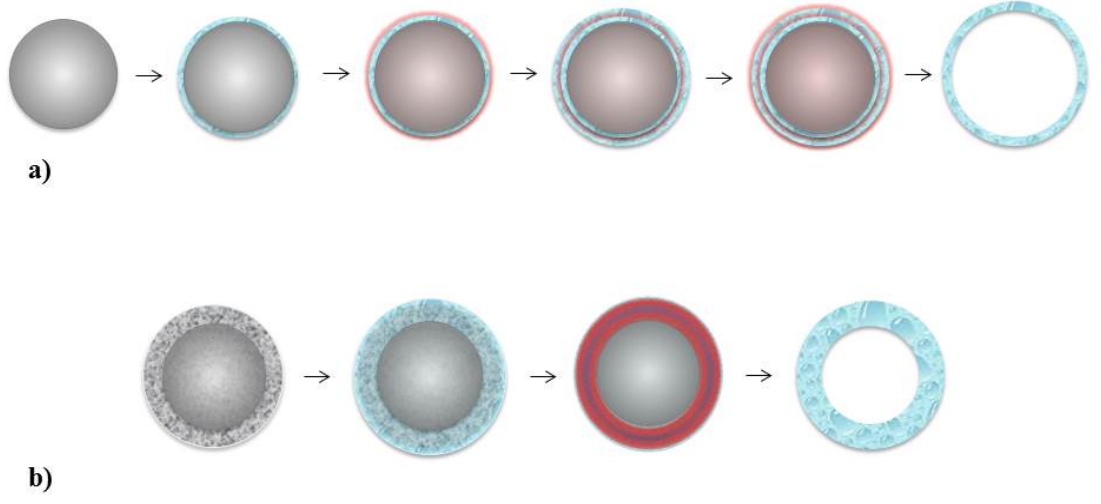
Figure 1. Schematic representation of ( a ) LbL assembly process, and ( b ) single step assembly with SC/MS silica template. In LbL assembly, a solid silica nanoparticle (grey) is coated with antigen (blue) by electrostatic interaction, followed by alternate deposition of polymers to create multiple layers by chemical cross-linking (red). The silica nanoparticle template is removed, leaving an antigen containing nanocapsule. In single step assembly, antigen or polymer is infiltrated into the mesoporous matrix (blue) of SC/MS silica nanoparticles (grey with mesh layer). Antigen or polymer is subsequently cross-linked (red), leaving hollow antigen-containing